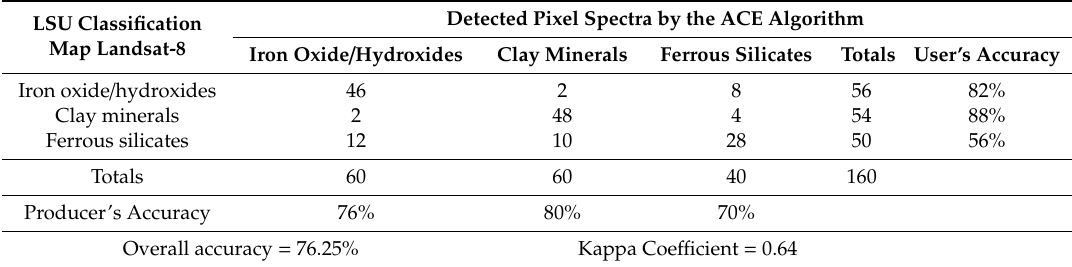
Table 6. Confusion matrix for the LSU classification image-maps derived from Landsat-8 versus the ACE fraction images derived from VINR + SWIR bands of ASTER.